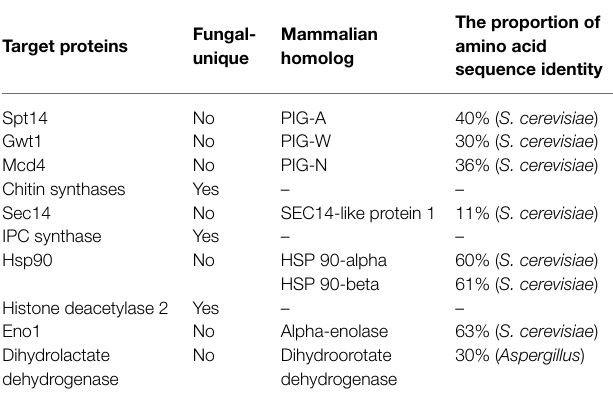
TABLE 2 | Comparison of amino acid consistency of target proteins between fungal and mammalian.